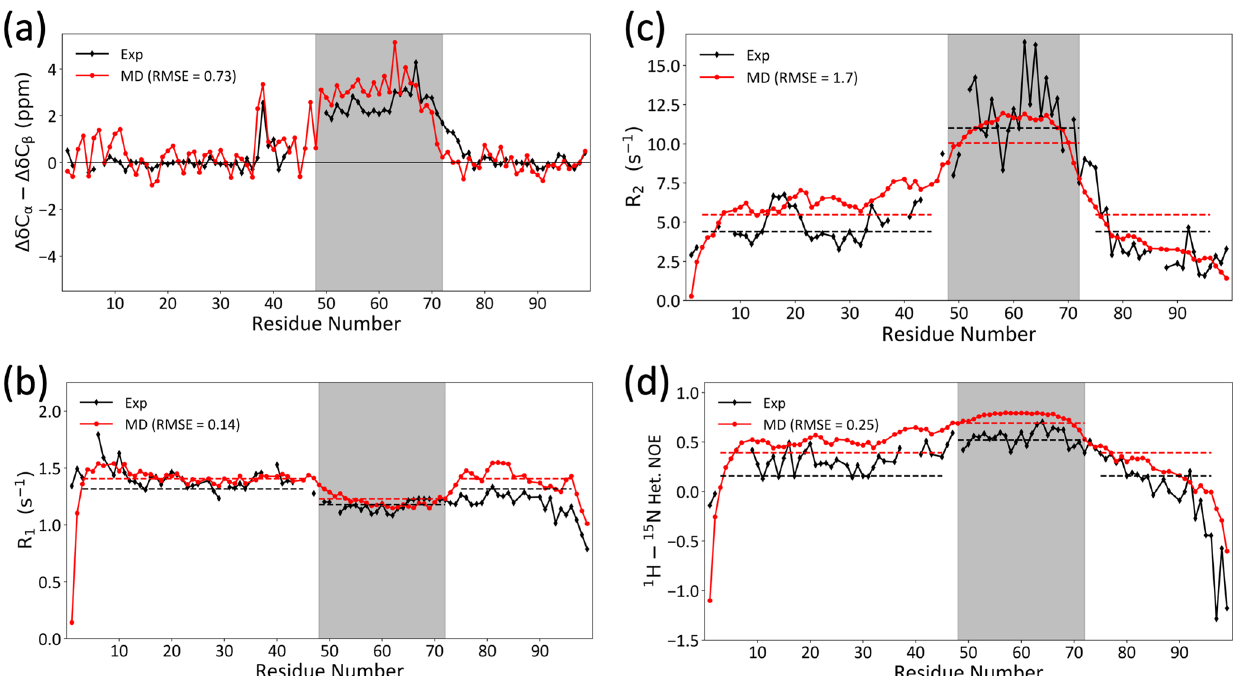
Fig. 2 Conformational and dynamic properties of FtsQ1-99 determined by solution NMR and MD simulations. a Secondary chemical shifts ( Δδ C α – Δδ C Δδ C – d R R β ). For Gly residues, only α are displayed. b 2 , 1 , and NOE. NMR data are shown in black; MD results are shown in red, with root-mean-square errors (RMSEs) indicated in legends. The core helical region, spanning residues 48 to 72, is shaded. Horizontal dashes indicate average values within the core helical region or non-helical region (residues 3 – 45 and 75 –